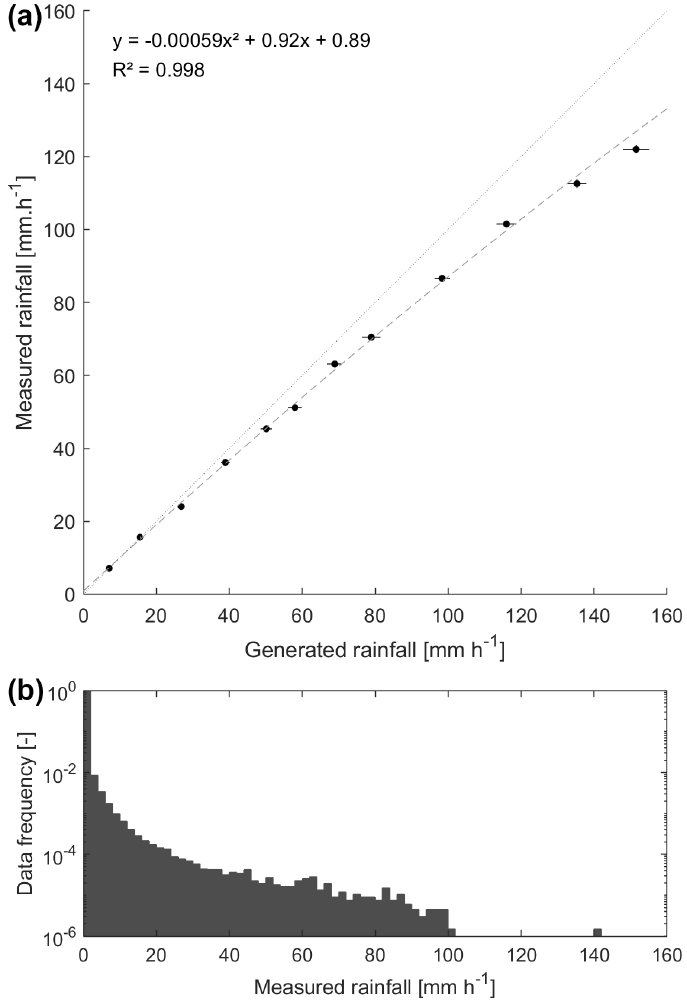
Figure A1. Calibration curve (a) of the Pluvimate rain gauges based on experimental measures with controlled rainfall input and (b) the data frequency measured in